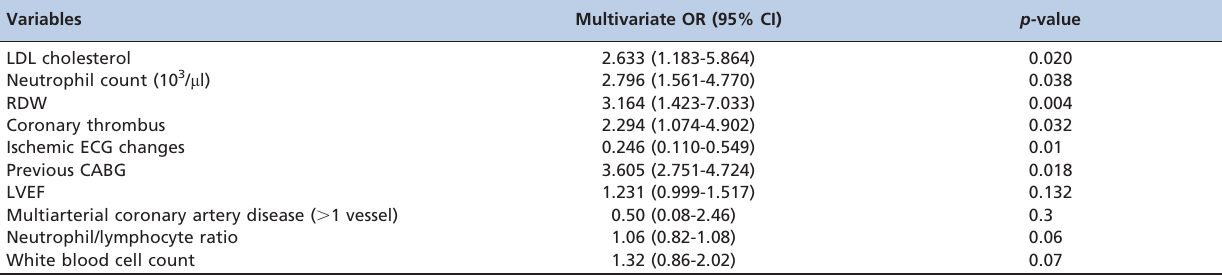
Table 4 - Independent predictors of NSTEMI in a multivariate logistic regression analysis. Variables